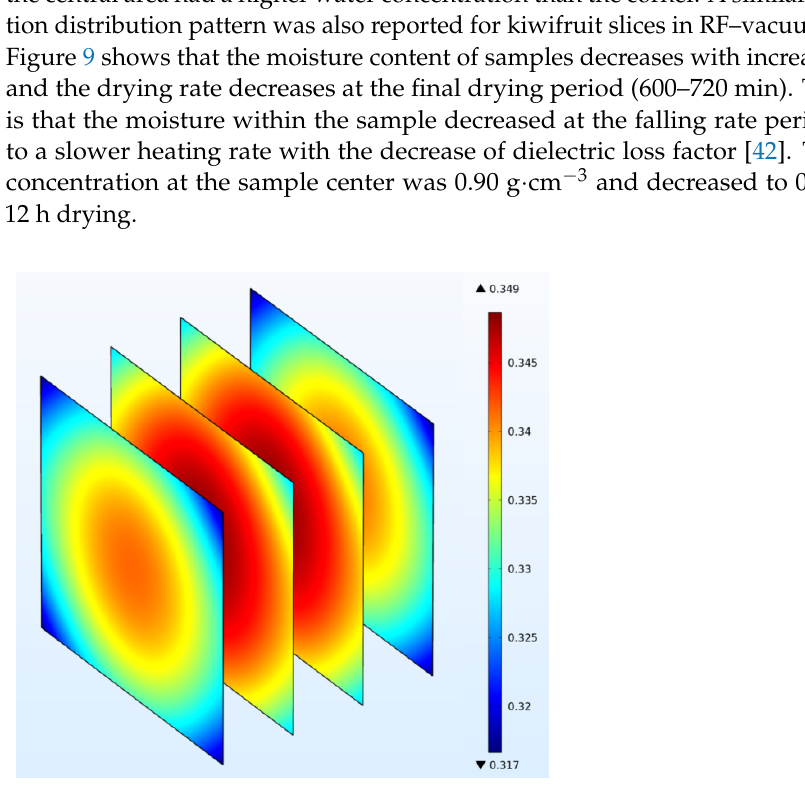
Figure 9. Water concentration at the center of potato samples during RF drying. 3.4. Vapor Migration Figures 10 and 11 show the water vapor concentration distribution in potato samples after drying and the water vapor concentration at the center point of the potato sample during drying over time from modeling. The distribution of water vapor concentration is related to the distribution of both the temperature and water content within the sample since higher temperature led to a higher evaporation rate of water vapor [43]. Results in ‐ dicate that the water vapor concentration at the sample center is greater than that at the corners because water vapor increased as temperature increased, and a pressure gradient from center to corner would guarantee the mass transfer from the sample to the surround ‐ ing area in the drying process. It can be seen from Figure 11 that the trend of water vapor concentration variation at the sample center corresponds to the change of temperature at the same spot, as shown in Figure 5. This indicates the temperature and water vapor con ‐ centration in the center of the sample increase as the electromagnetic energy continually converts to heat energy. This is due to the selective heating mechanism of RF heating: the